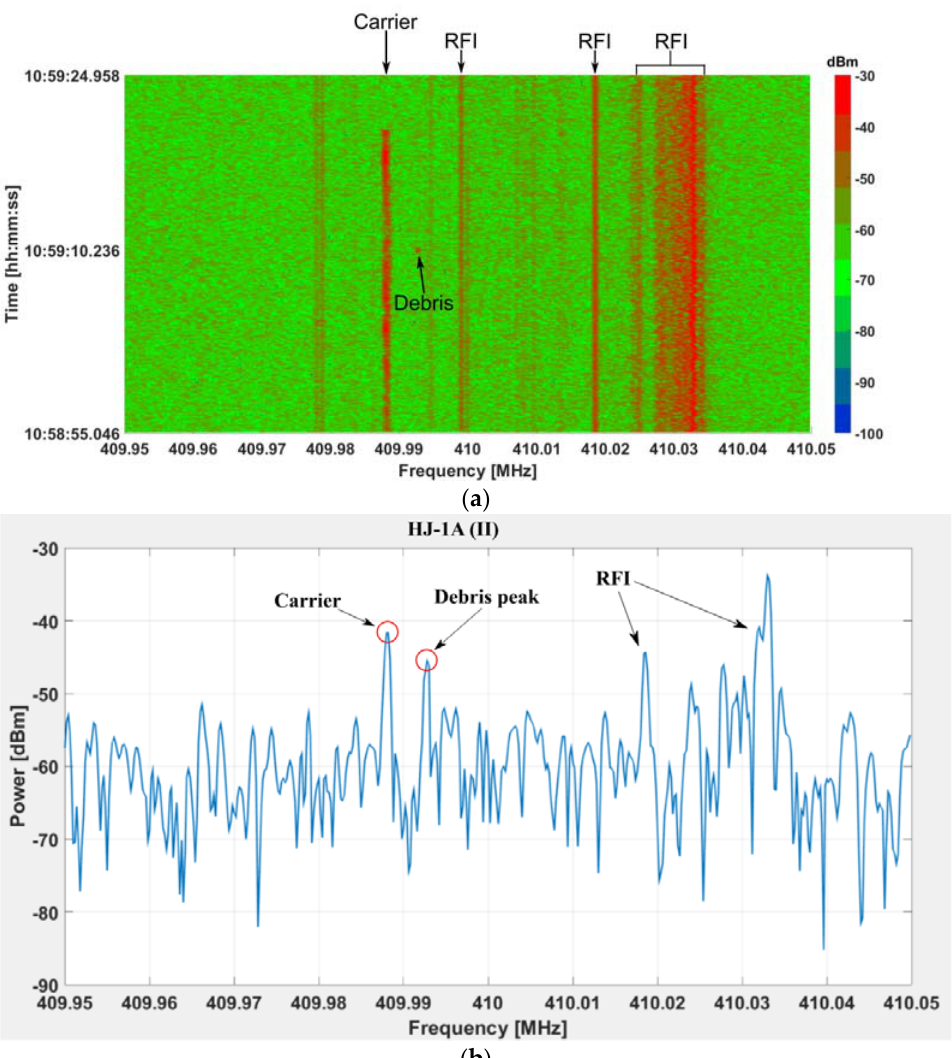
Figure 6. Debris HJ ‐ 1A (second passage): ( a ) spectrogram; ( b ) screenshot of the spectrum analyzer at the center of the visibility interval (Table 4).